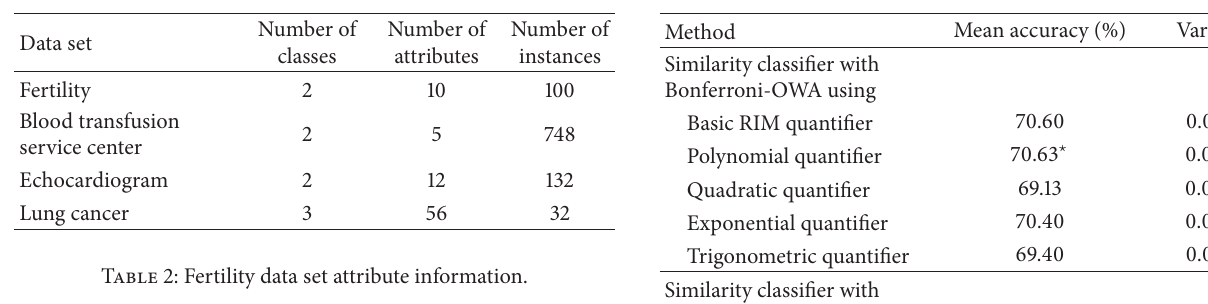
Table 1: Data sets used and their main properties.